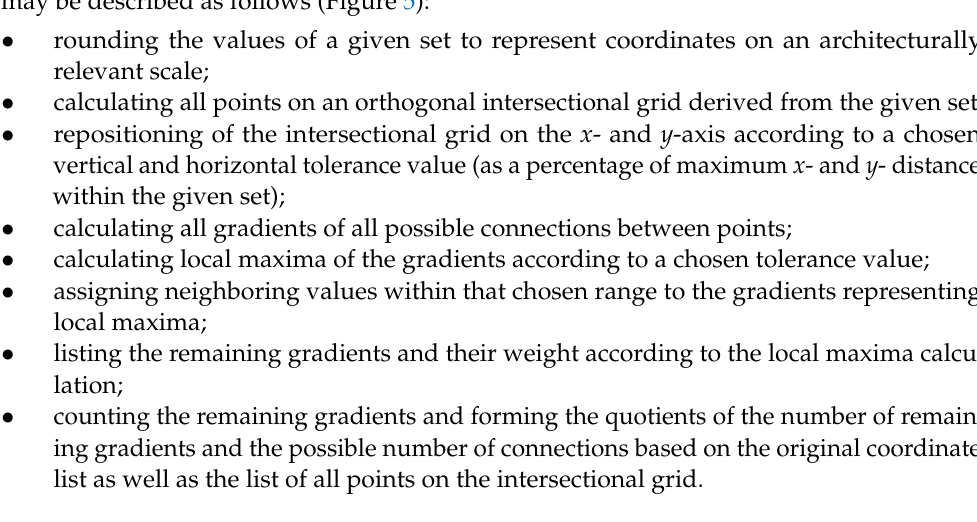
Figure 4. Calculation of distinct gradients based on local maxima within a given range.